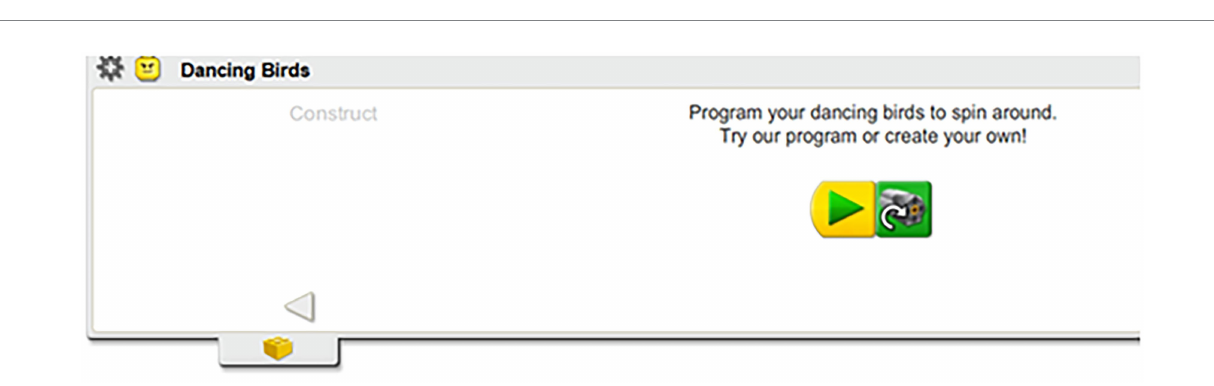
FIGURE 2 Instructions on WeDo computer program to learn how to program the dancing bird